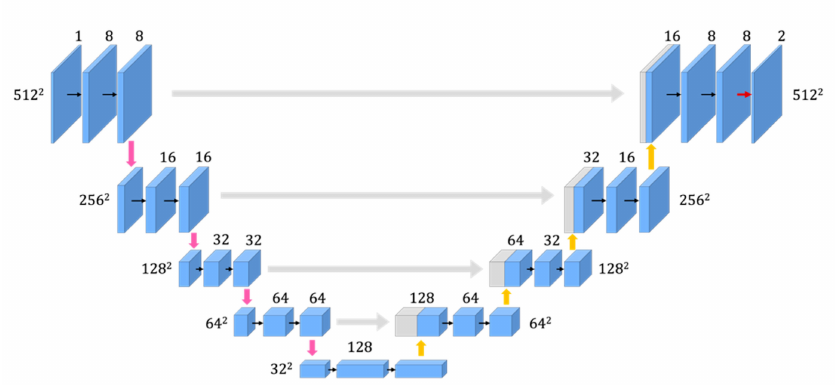
Figure 3. Improved U-Net (U-Net #1) with fewer channels than the conventional architecture.